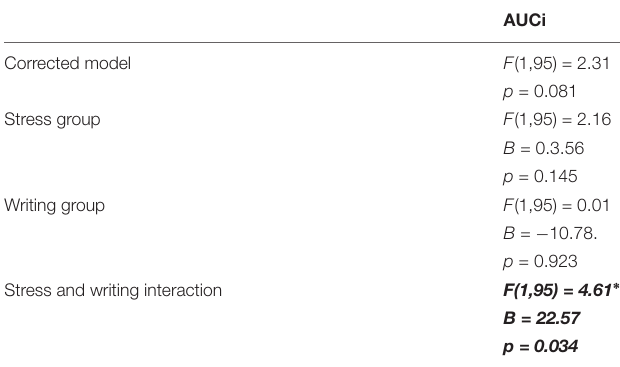
TABLE 3 | Effects of stress and writing manipulations on AUCi cortisol levels (full two-way ANOVA